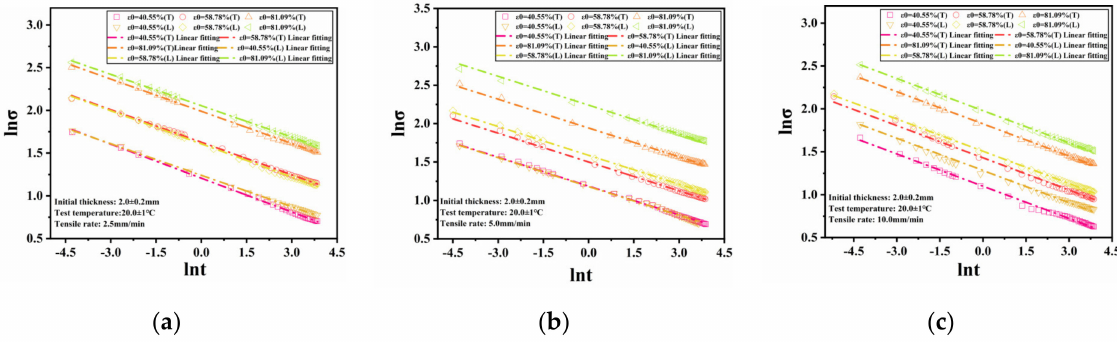
Figure 5. Fitting results of the curves: ( a ) v = 2.5 mm/min; ( b ) v = 5.0 mm/min; ( c ) v = 10.0 mm/min.